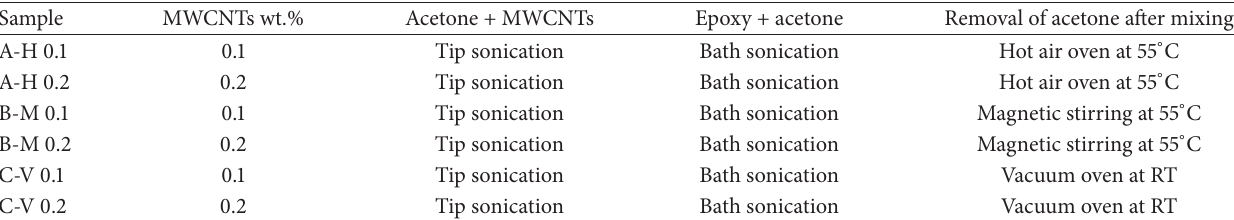
Table 1: Different methods for MWCNTs